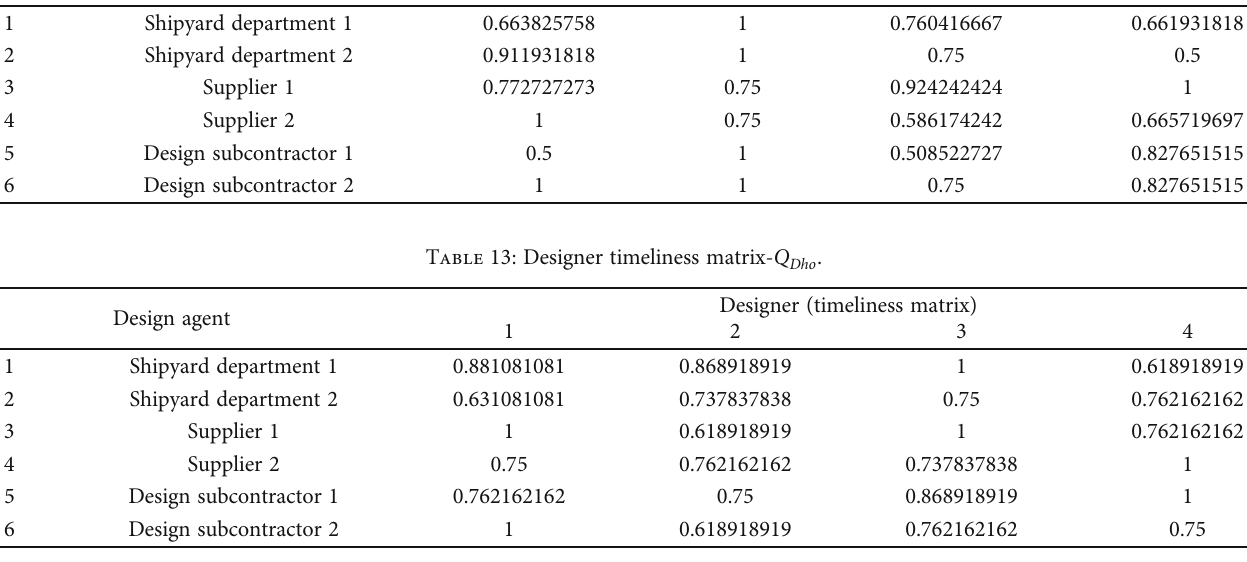
Table 12: Designer ’ s ability attribute matrix- Q